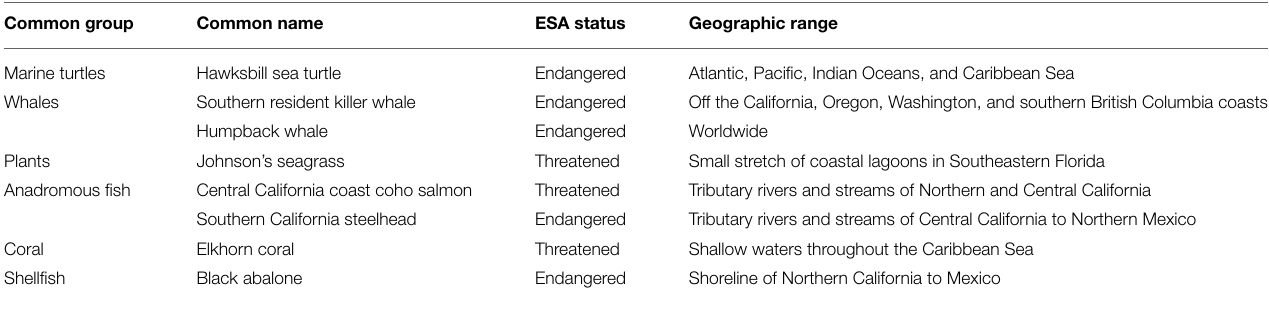
TABLE 1 | Species in the stated preference choice experiment survey. Common